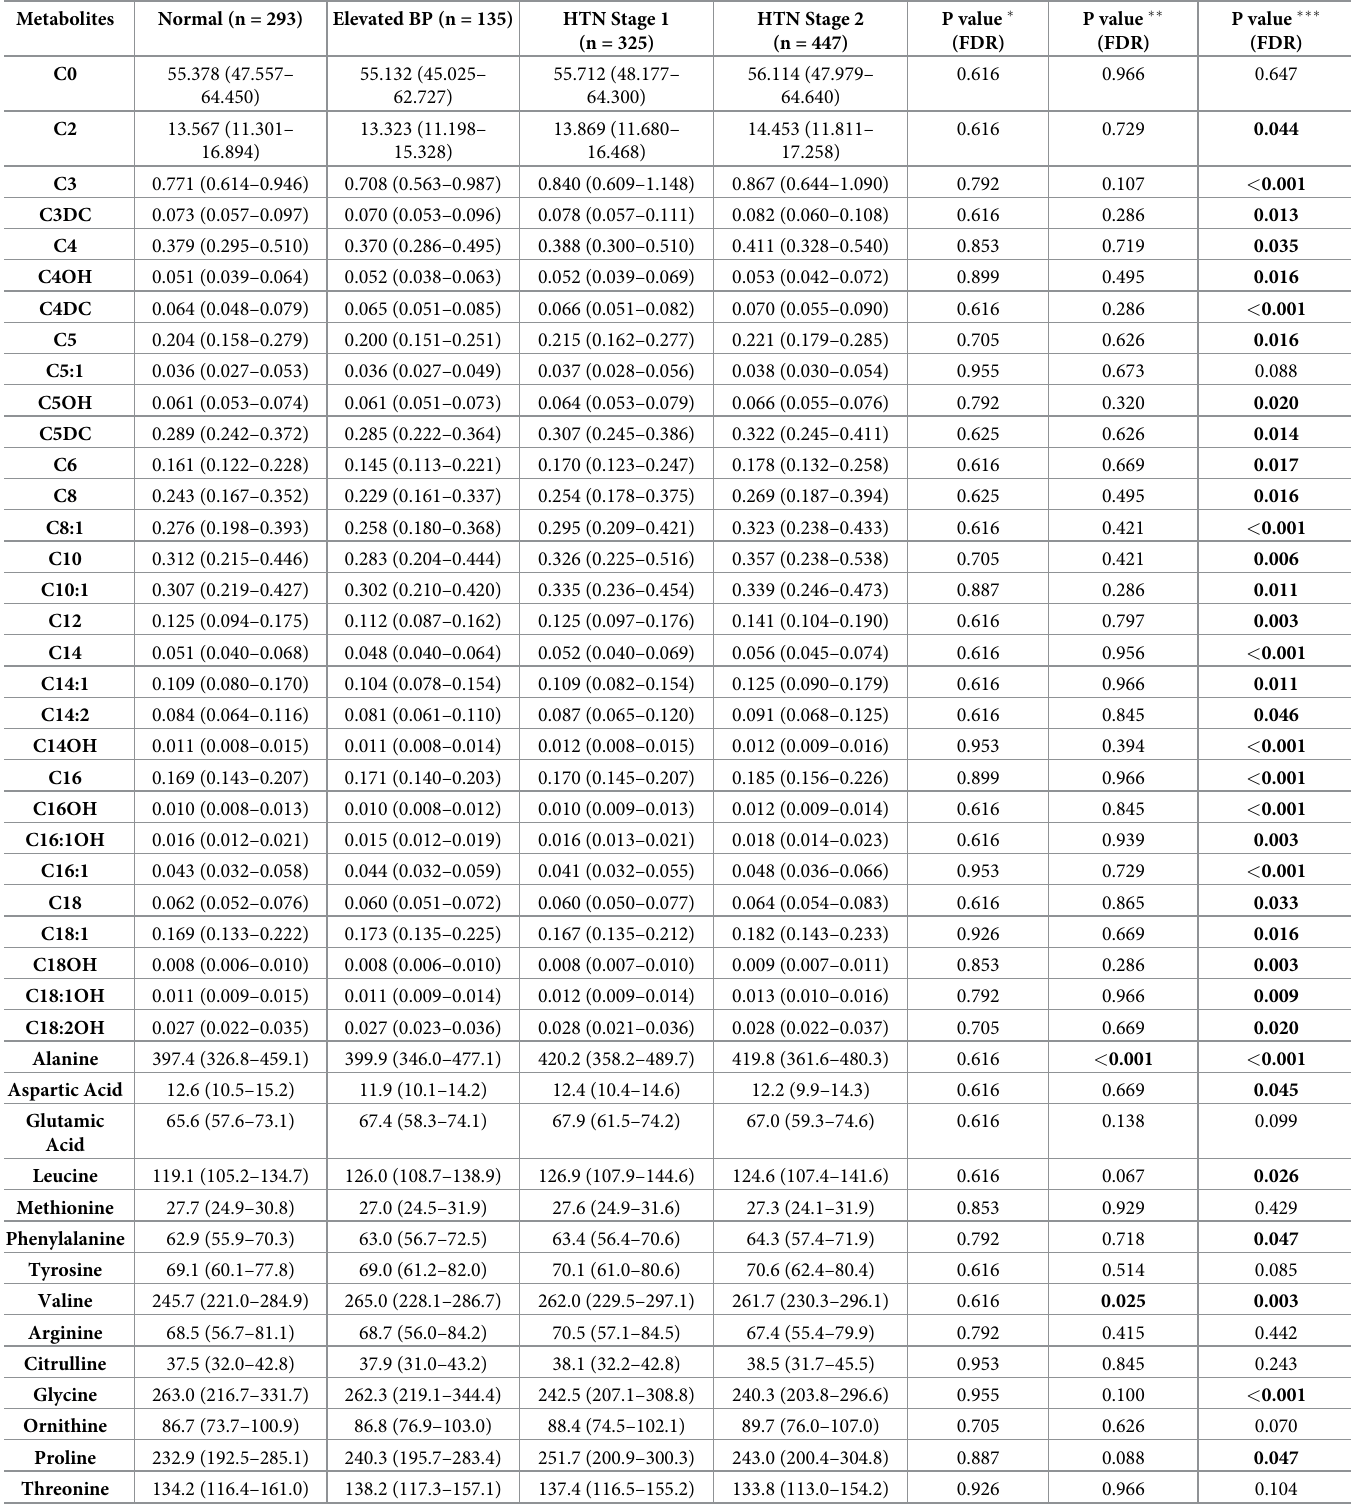
Table 2. The plasma concentration of acylcarnitines and amino acids.